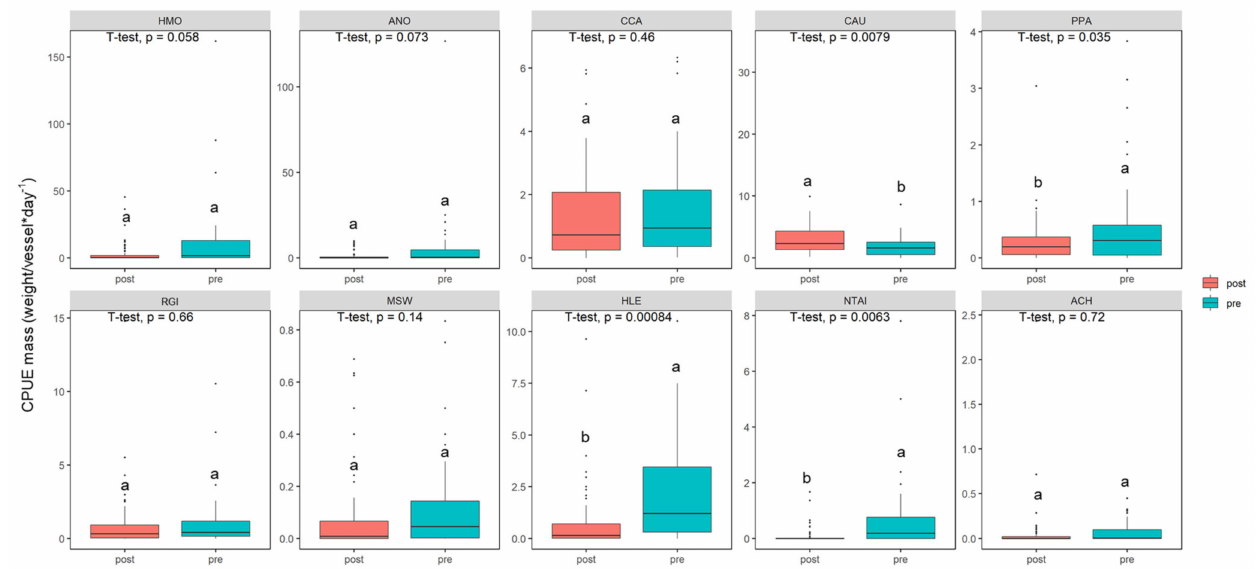
Figure 5. The box whisker plots comparing pre- and post-Japanese smelt CPUEs for 10 dominant fish species. Each box shows the median value, the bottom and top of the box indicate the first and third quartiles, respectively, and the error bars indicate the 10th and 90th percentiles. A t-test was conducted to compare CPUEs for two different time periods ( p < 0.05 indicated a significant difference). Lowercase letters a and b were used to determine whether there was a difference between pre- and post-Japanese smelt ( p < 0.05). HMO (Silver carp): Hypophthalmichthys molitrix , ANO (Bighead carp): Aristichthys nobilis , CCA (Common carp): Cyprinus carpio , CAU (Crucian carp): Carassius auratus , PPA (Topmouth gudgeon): Pseudorasb- ora parva , RGI (Barcheek goby): Rhinogobius giurinus , MSW (Swinhon’s sleeper): Micropercops swinhonis , HLE (Sharpbelly): Hemiculter leucisculus , NTAI (icefish): Neosalanx taihuensis , ACH (Khanka spiny bitterling): Acheilognathus chankaensis